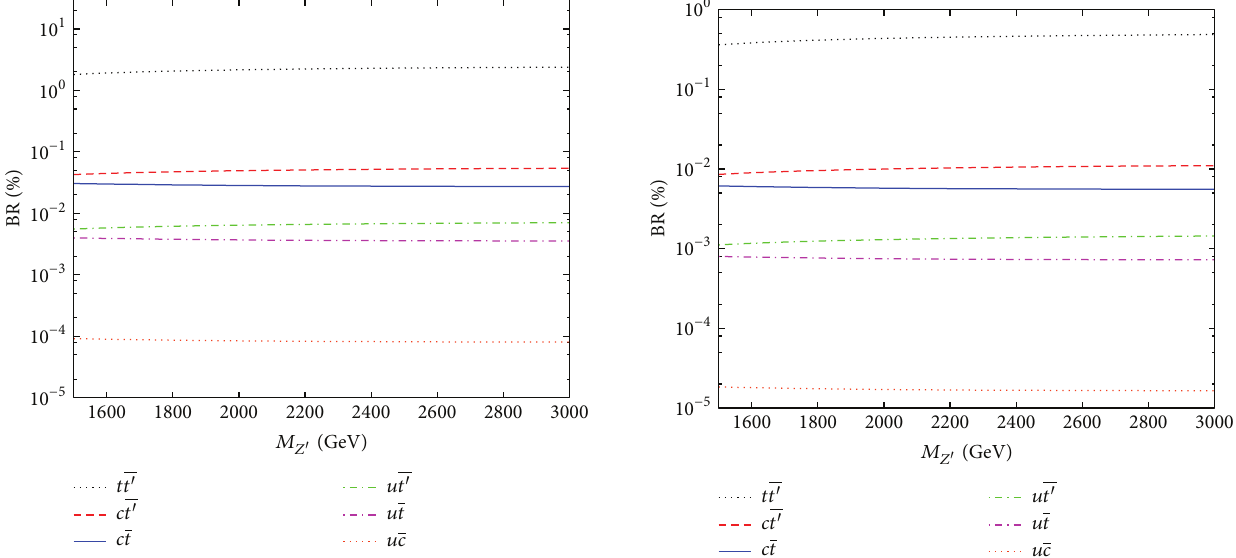
Figure 5: Branching ratios (%) depending on the mass of the 𝑍 󸀠 boson for FCNC couplings to different flavors of up-sector quarks within the 𝑍 󸀠 𝜒 model. Here the mass of 𝑡 󸀠 quark is 700 GeV and the FCNC parameter 𝑥 = 0.1 .